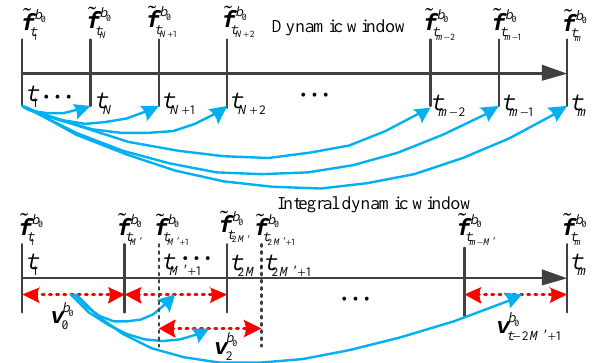
Figure 2. Integral dynamic window algorithm diagram. indicates the calculated gravitational acceleration projected erometer output